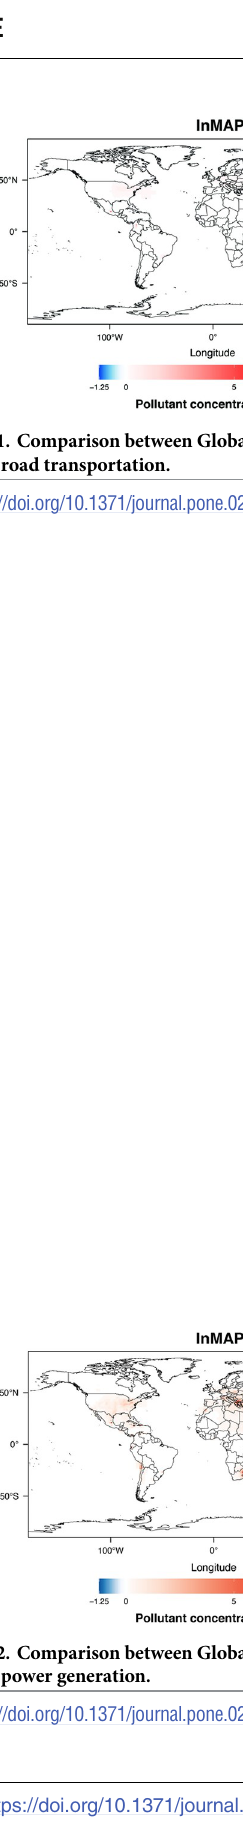
PLOS ONE | https://doi.org/10.1371/journal.pone.0268714 May 25,